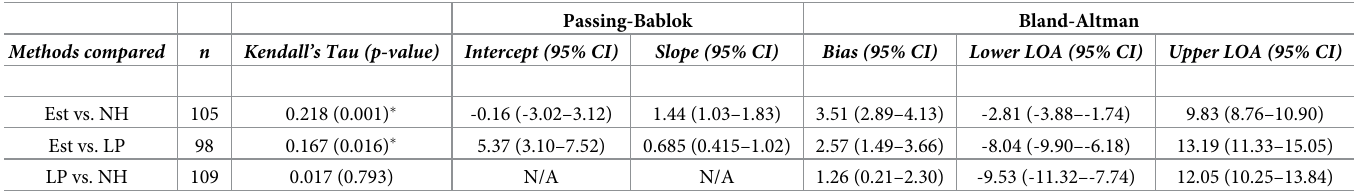
Table 4. Agreement between total white blood cell counts determined using the Natt and Herrick, Leukopet, and blood slide estimate methods in clinically healthy subadult radiated